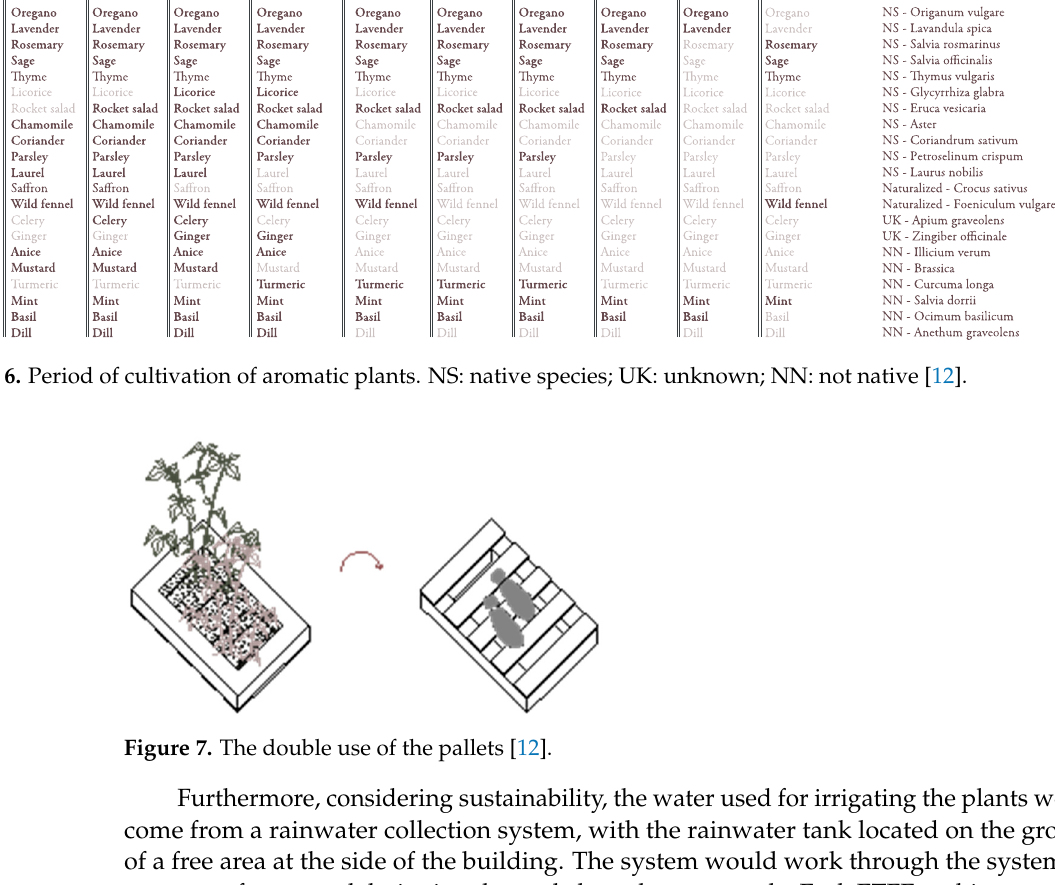
Figure 5. Period of cultivation of vegetables. NS: native species; UK: unknown; NN: not native [12].